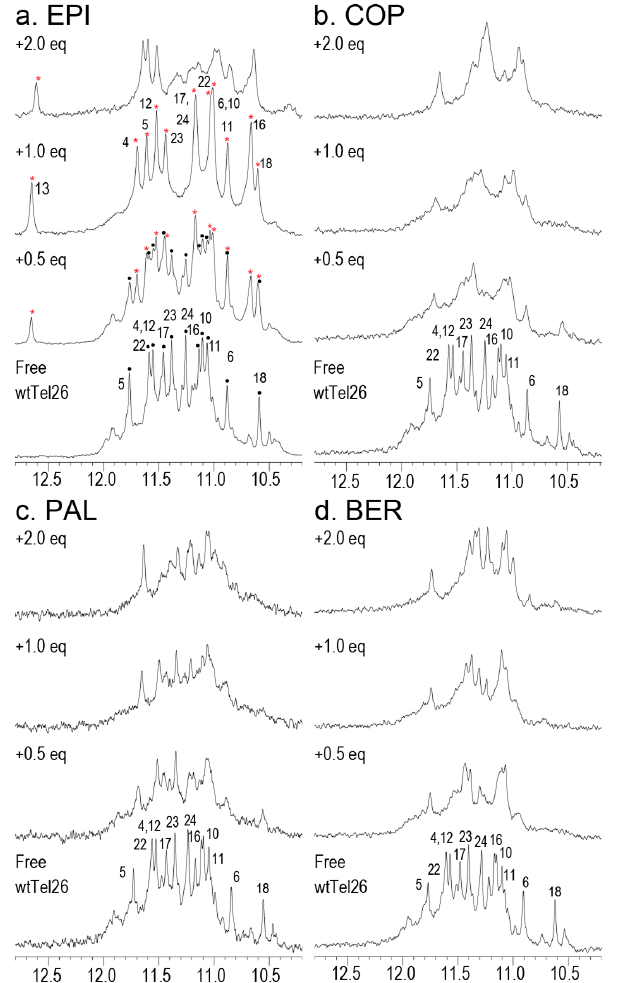
Figure 8. The 1 H ‐ NMR imino region in the presence of protoberberine alkaloids titration to wtTel26: ( a ) EPI, ( b ) COP, ( c ) PAL, and ( d ) BER. The assignments of the free wtTel26 in K + ‐ containing solution are shown. Also shown in ( a ) are the assignments of EPI ‐ wtTel26 complex (red asterisks) and free DNA (black dots). Table 3. The DDM ‐ calculated absolute binding free energies ∆𝐺 (cid:3029)(cid:3036)(cid:3041)(cid:3031)(cid:3042) of ligand binding to wtTel26. Unit: kcal/mol.